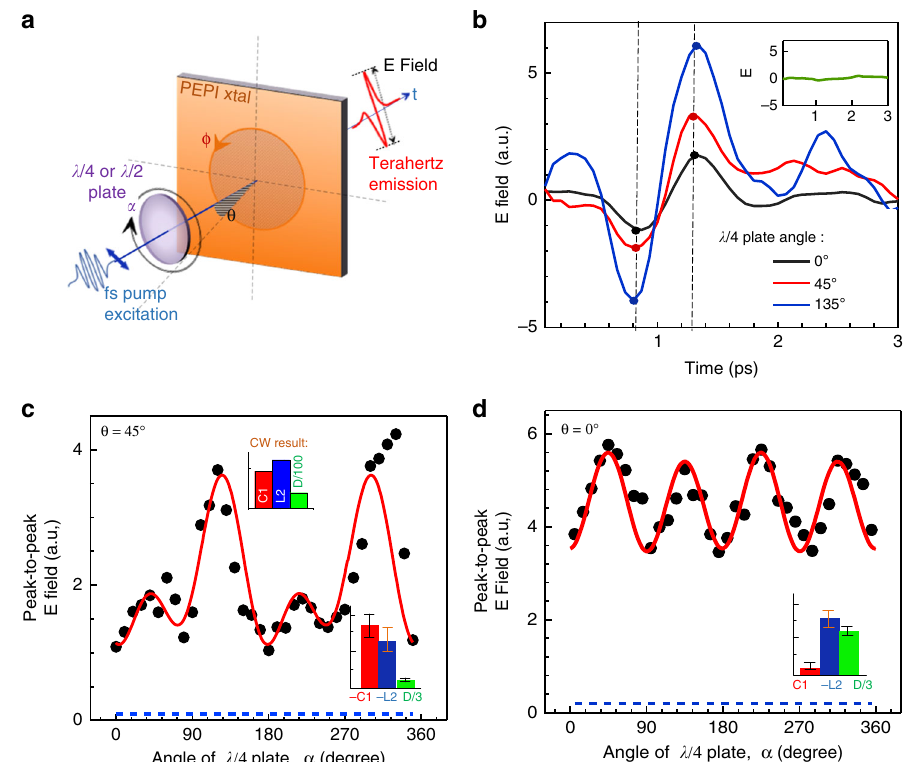
Fig. 3 Terahertz (THz) emission due to ultrafast photogalvanic (PGE) currents in 2D-PEPI crystal. a schematic illustration of the experimental setup for the THz emission measurements. The angles α , θ , and φ are denoted. b THz time-domain emission waveforms measured at λ /4 waveplate angle, α of 0°, 45° and 135 ˚ as denoted, that correspond to linear polarized (LP), right circularly polarized (RCP) and left circularly polarized (LCP) light. The two dashed black lines mark the times where positive and negative peaks of the terahertz emission were determined. The peak-to-peak values are determined from the addition of the absolute positive and negative values as marked by the dots. The inset shows a null signal obtained when resonantly excited at the exciton band (2.34 eV). c Terahertz fi eld emission vs. the rotation angle, α , photogenerated using 3.06 eV pulsed excitation at θ = 45°. The red line through the black data points is a fi t using Eq. (1). The inset shows the obtained relative values of the coef fi cients C1 , L2 , and D ; d Similar measurements as in panel c , for incident angle, θ = 0 ˚ . The fi t using Eq. (1) shows majority contribution from L2 . The blue dashed line marks the noise level corresponding to zero emission fi